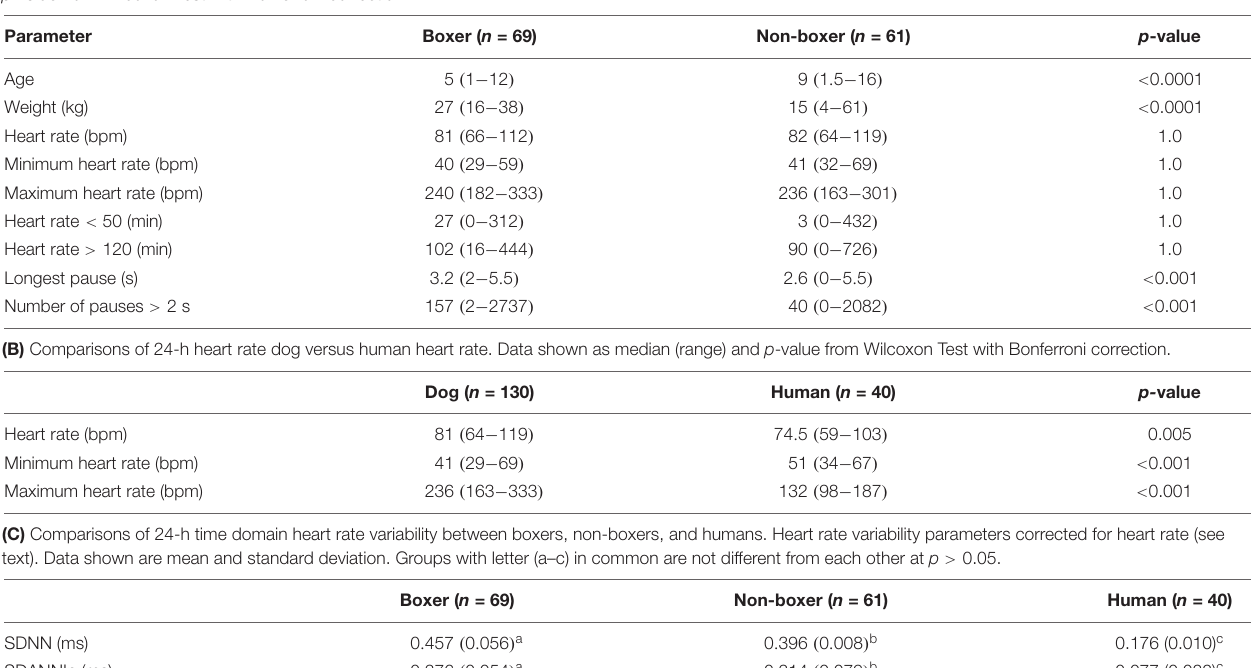
TABLE 1 | Heart rate and heart rate variability comparisons. (A) Comparisons of populations and 24-h heart rate characteristics boxer versus non-boxer (31 other dog breeds represented). Data shown as median (range) and p -value from Wilcoxon Test with Bonferroni correction.